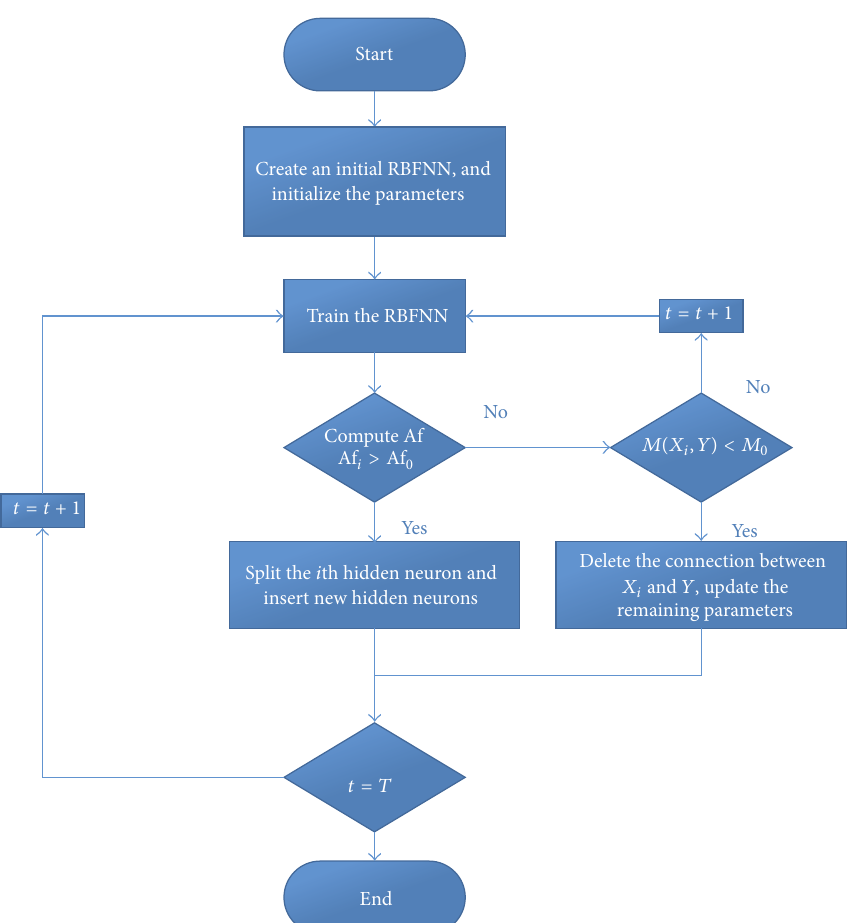
Figure 2: Flow chart of the FS-RBFNN.